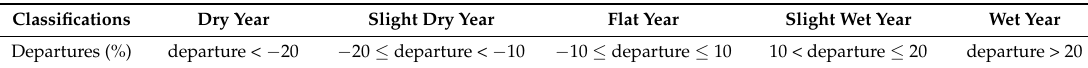
Table 2. Annual runoff classification.